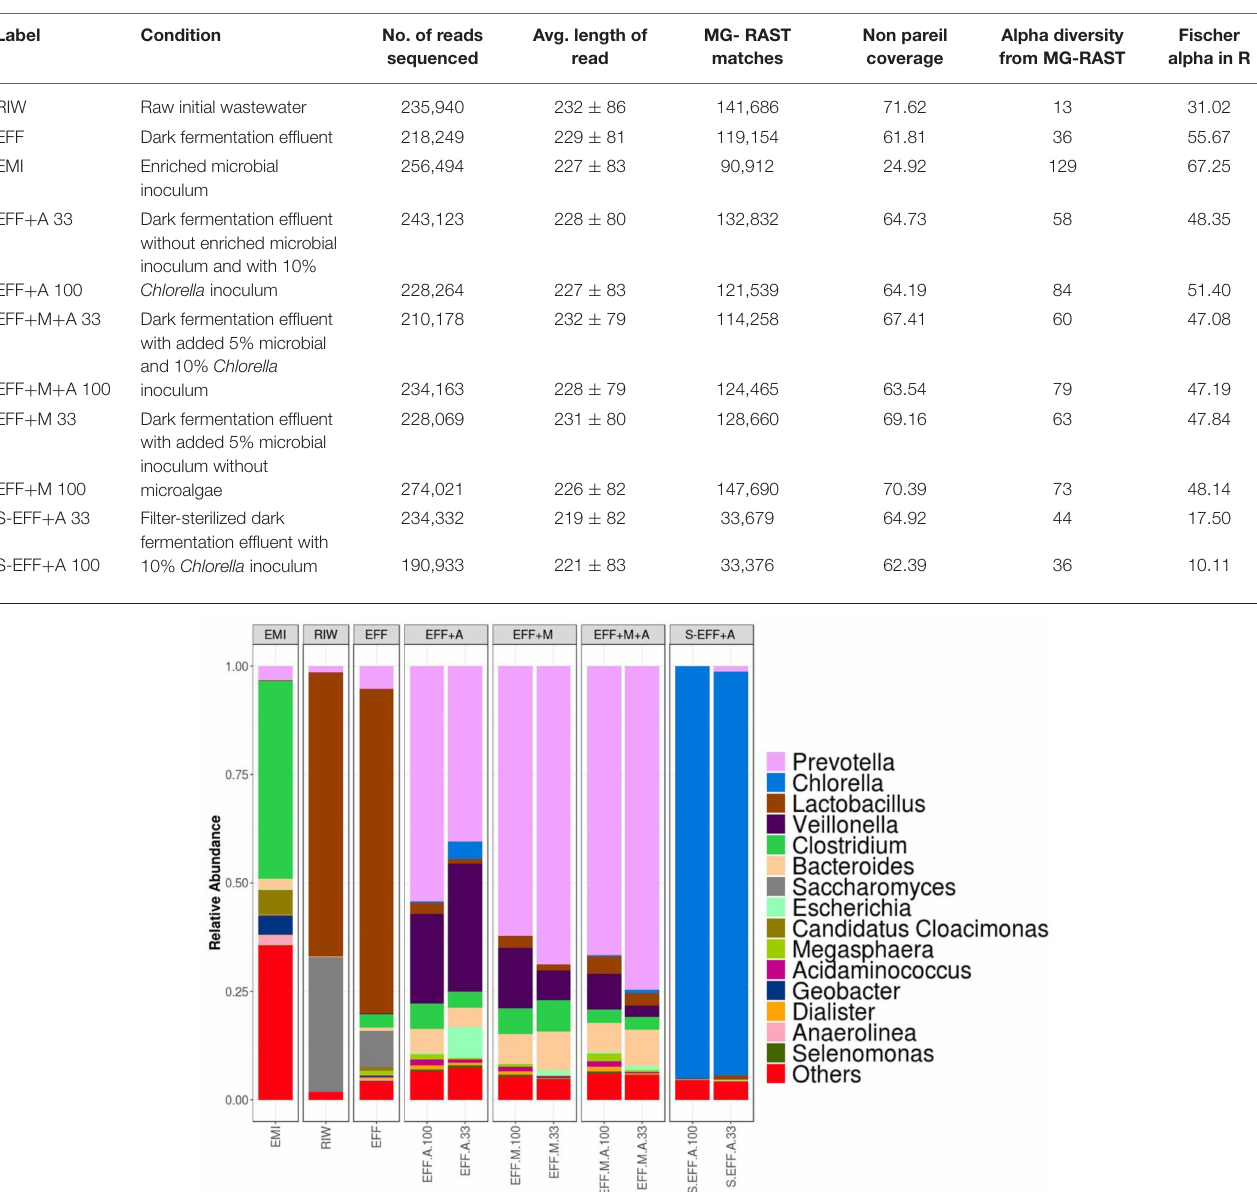
TABLE 2 | Sequencing data and alpha diversity metrics. Label